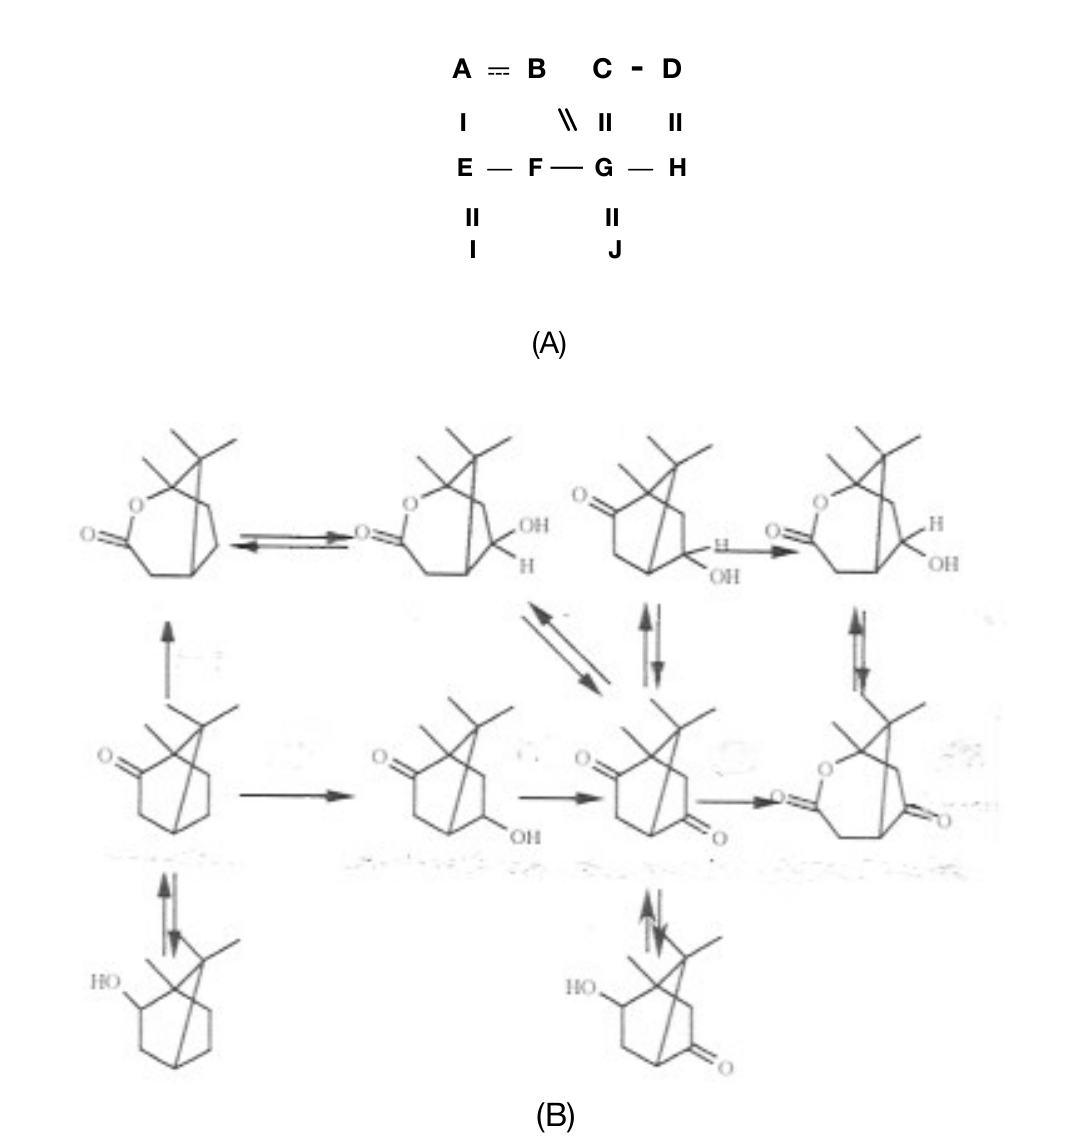
Figure 5. ( A ) The initial cartoon [35], and subsequent proposal ( B ) [38] for a speculative ‘metabolic grid’ for the early Figure 5. metabolism of (+)-camphor based on the characterised reactions catalysed by partially purified preparations of the enzymes camphor 5-monooxygenase, exo hydroxycamphor dehydrogenase, endo hydroxycamphor dehydrogenase, and 2,5-DKCMO ( E 2 ). A. 1,2-campholide; B. 5- exo hydroxy-1,2-campholide; C. 5- endo hydroxycamphor; D. 5- endo hydroxy-1,2-campholide; E. (+)-camphor; F. 5-exohydroxycamphor; G. 2,5-diketocamphane; H. 5-oxo-1,2-campholide; I. borneol; J.